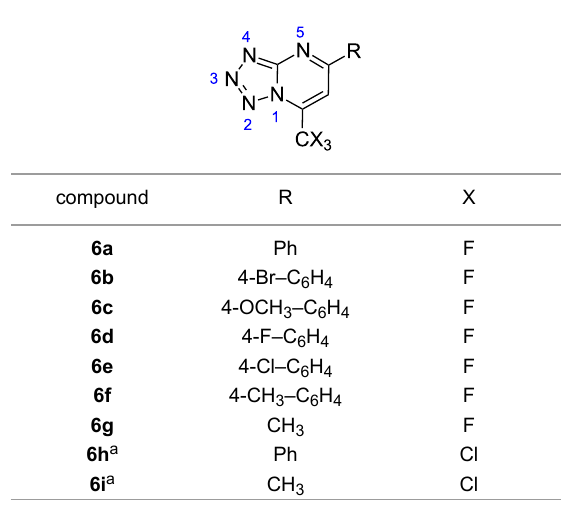
Table 3: Structures of trihalomethylated tetrazolo[1,5- a ]pyrimidines.